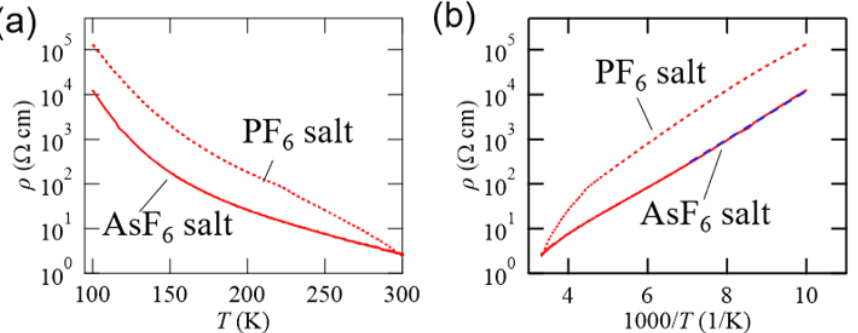
Figure 2. ( a ) Temperature dependence of the electrical resistivity ρ . ( b ) Arrhenius plot. The red dashed lines are the results for the PF 6 salt, which are taken from ref. [12]. The blue dashed line exhibits the fitting curve to estimate an activation energy.